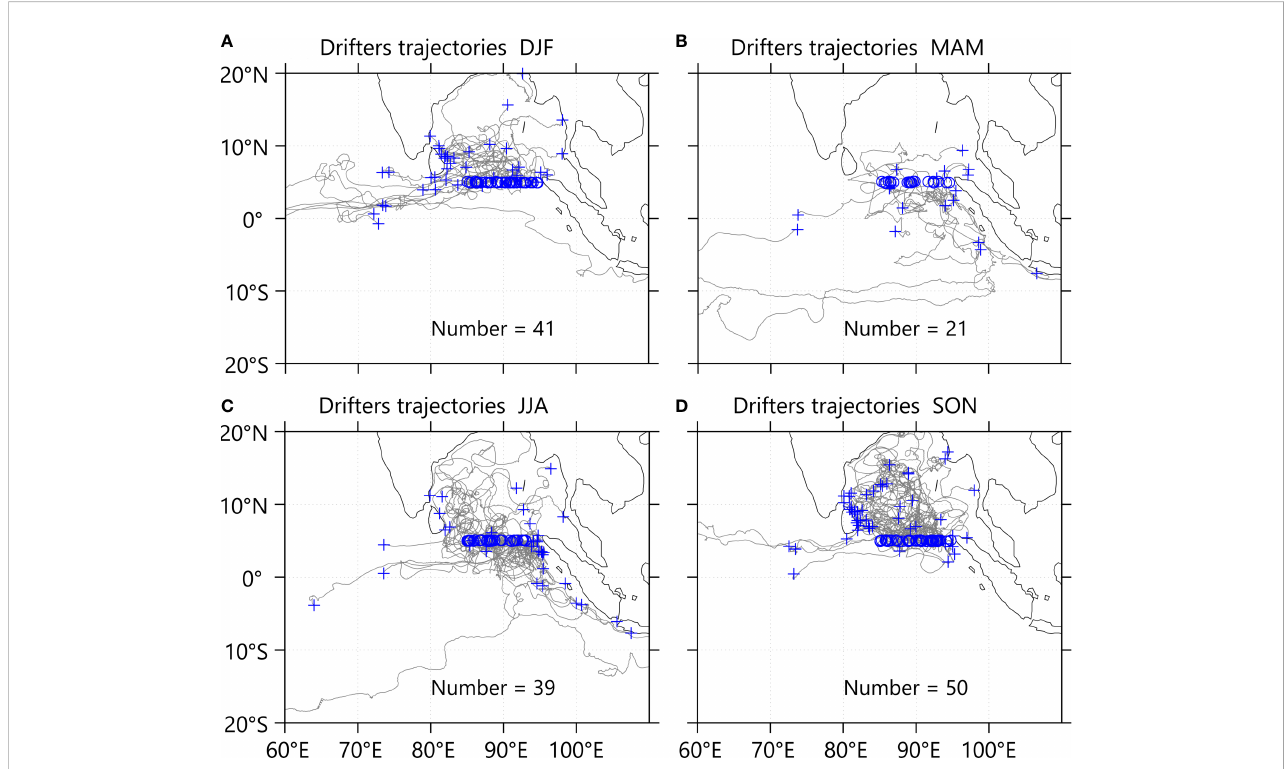
FIGURE 7 Trajectories of surface drifters (Total number = 151) from the GDP starting within the northern reach of the EIO (5°N, 85°E-95°E). The surface drifters are released in boreal (A) winter, (B) spring, (C) summer, and (D) fall, respectively. The gray lines indicate the trajectories of the surface drifter. The blue circles and plus signs represent the initial and fi nal positions of the trajectories,